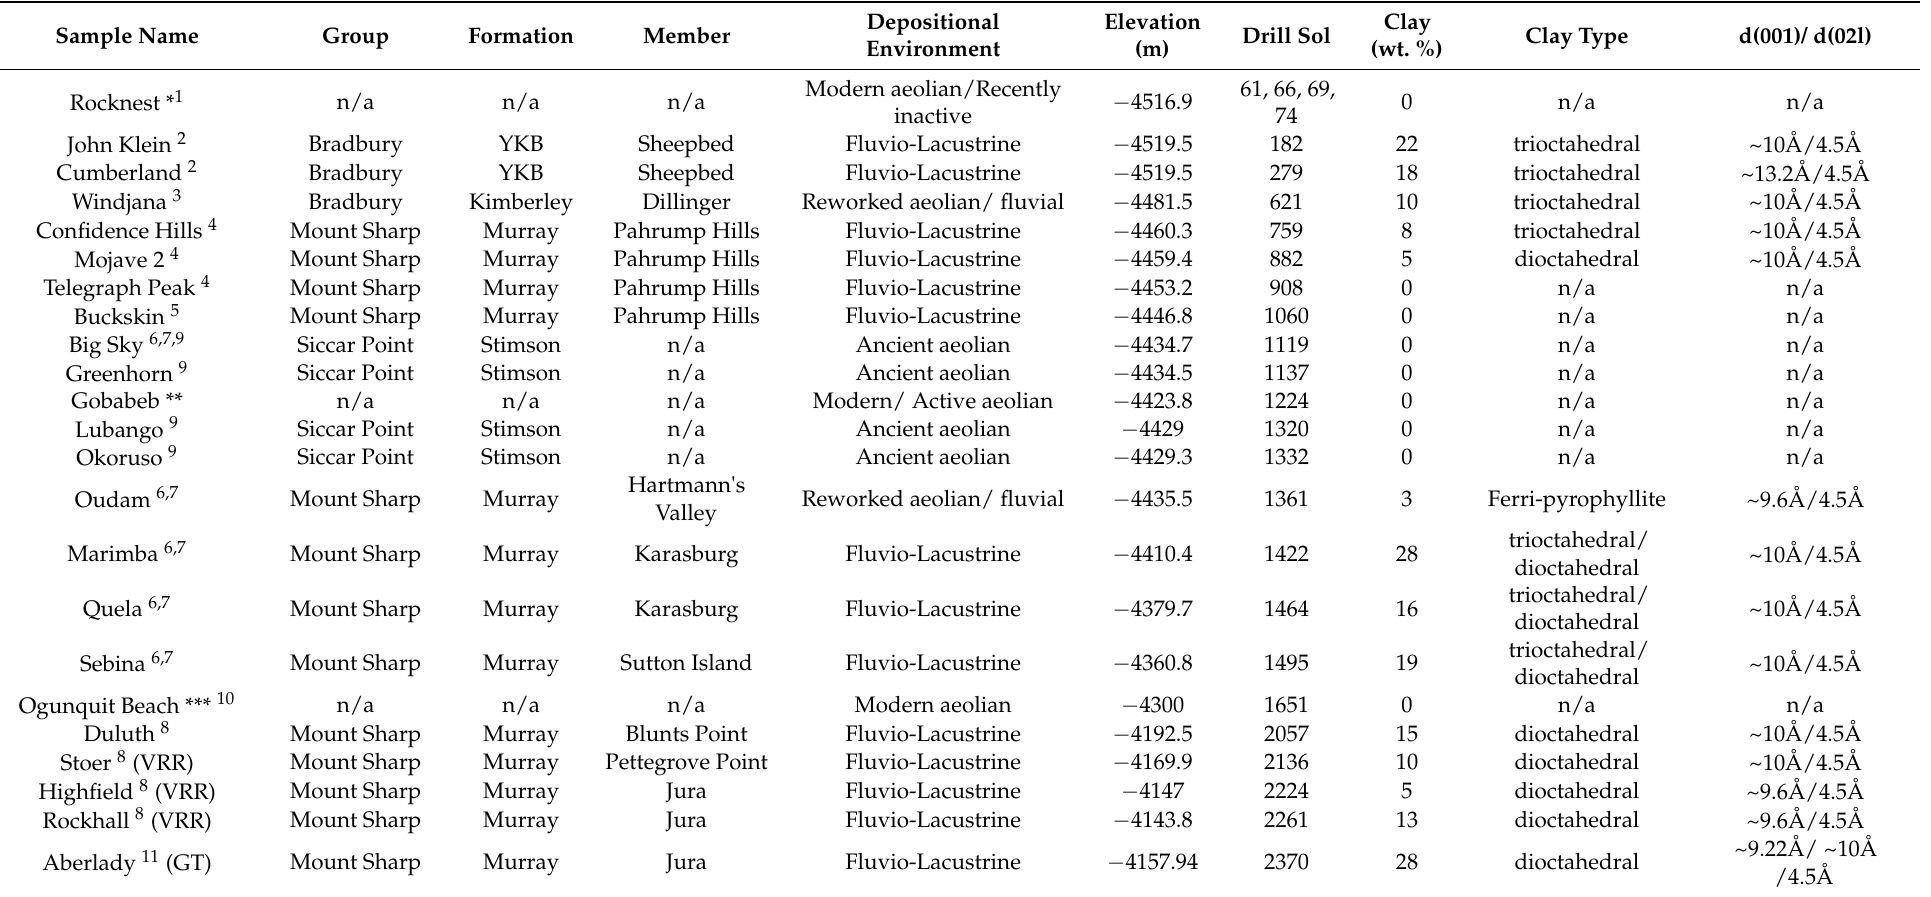
Table 1. Comprehensive table of drilled and scooped samples analyzed by